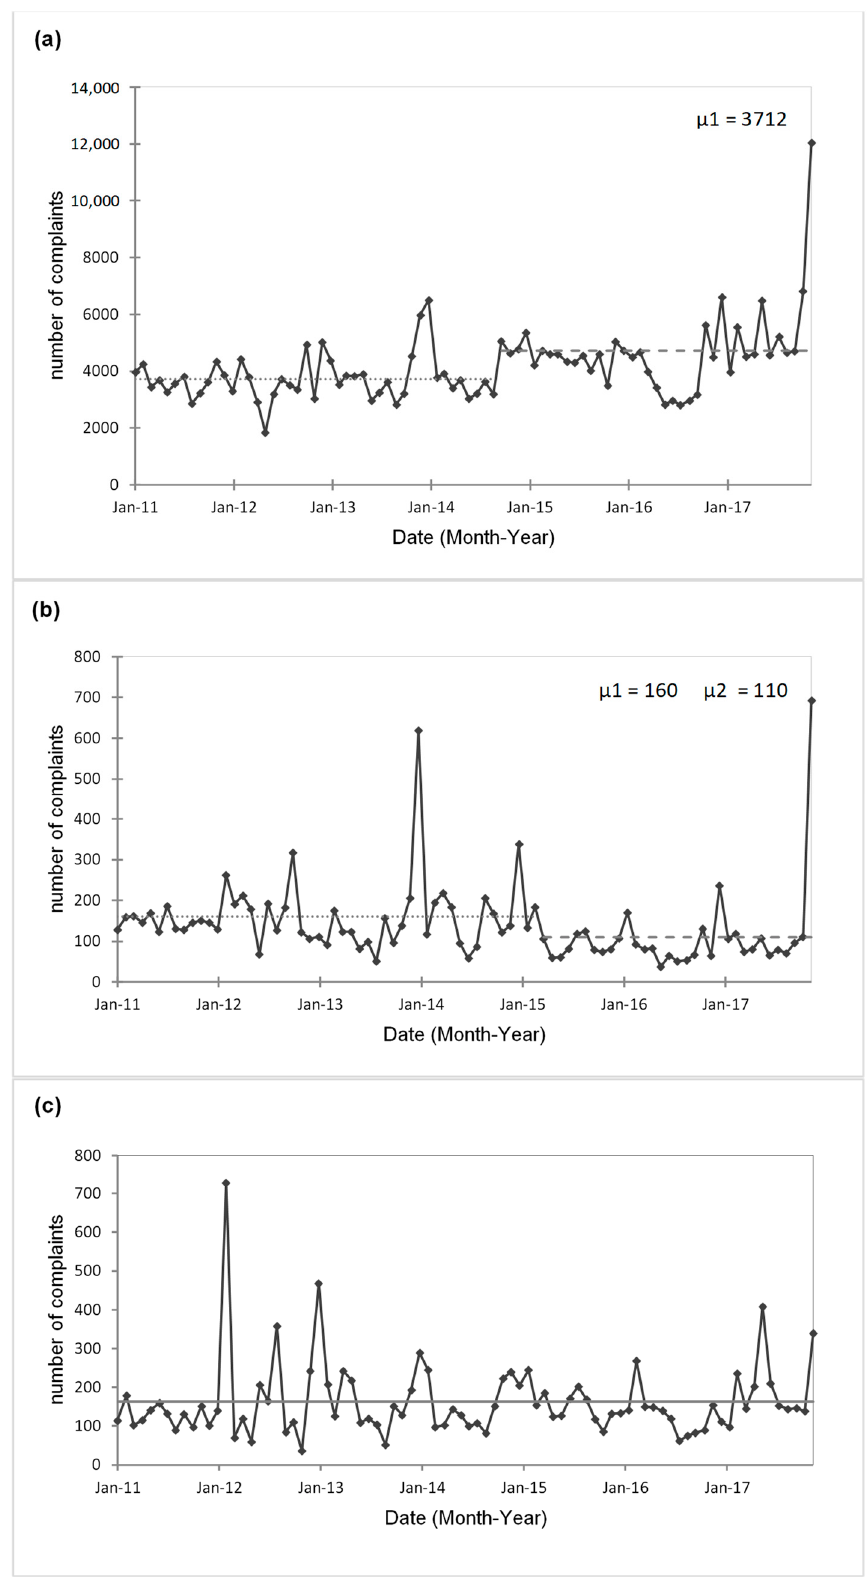
Figure 3. Time-series analysis of complaints. ( a ) City of Salta; ( b ) System No. 1; and ( c ) System No. 2. The date format for the x-axis is month-year. Significant shifts and their values from Pettit analysis are indicated by µ 1 (dotted line) and µ 2 (dashed